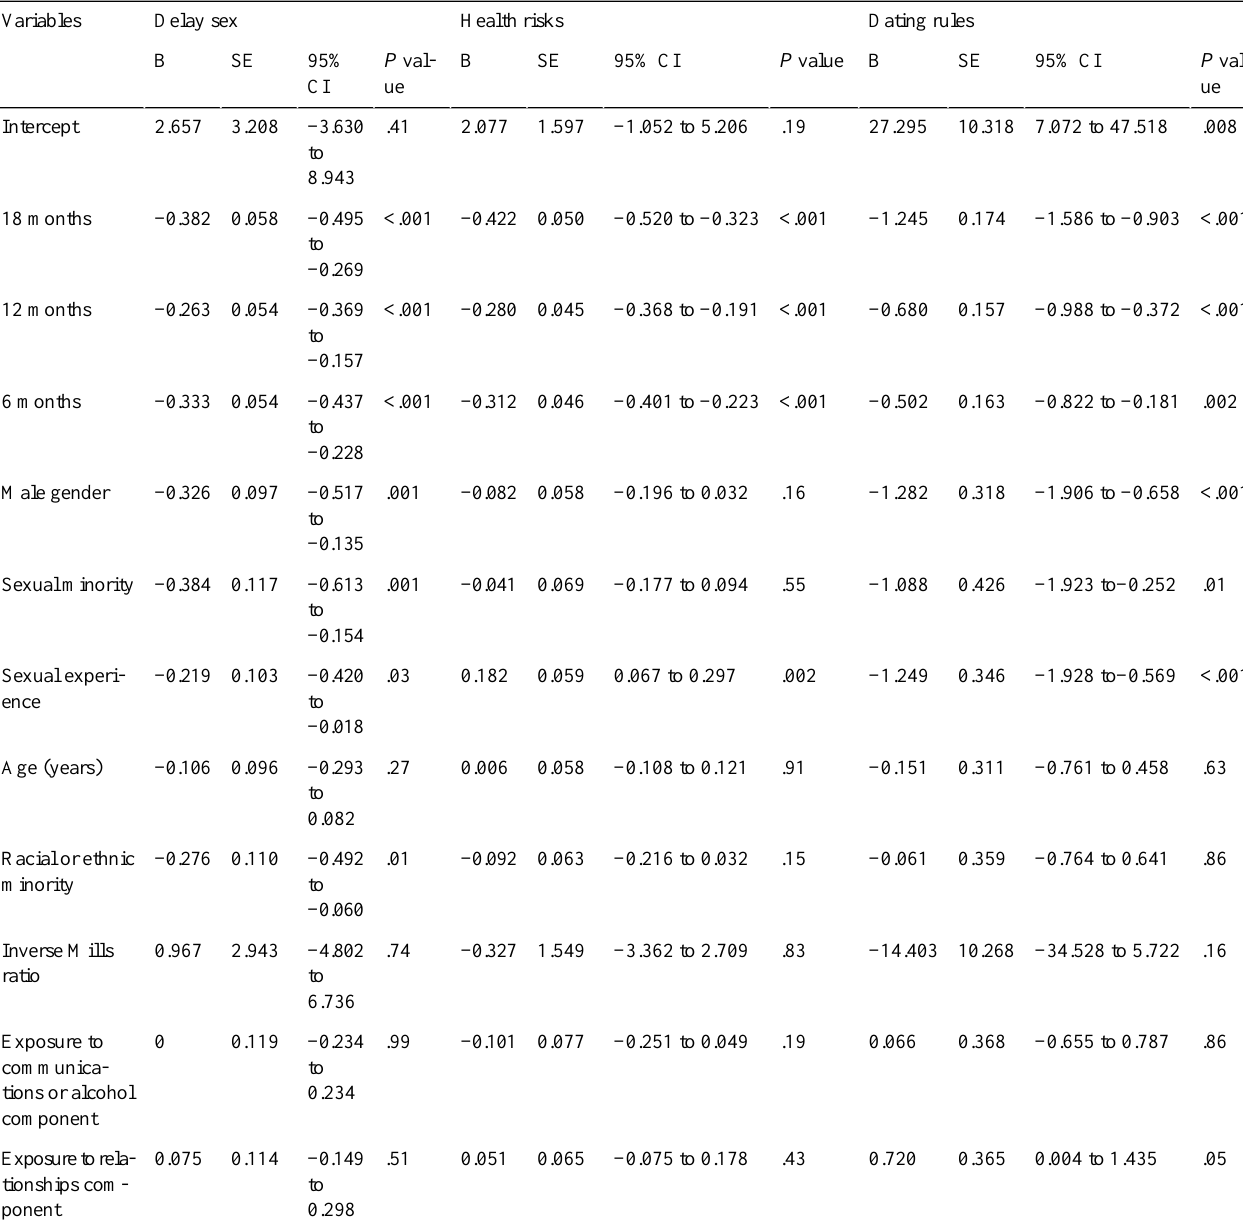
Table 3. Results from generalized estimating equations: main effects of intervention exposure on adolescent report of sexual communication: cautionary communication (T0: n=411; T1: n=325; T2: n=311; T3: